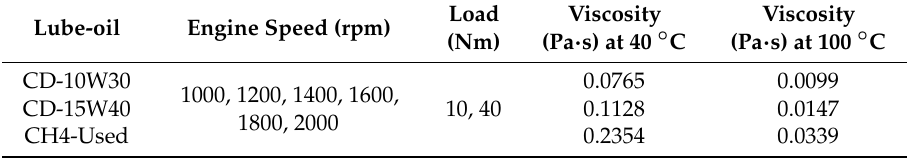
Table 2. Engine operating conditions and lubricants tested.